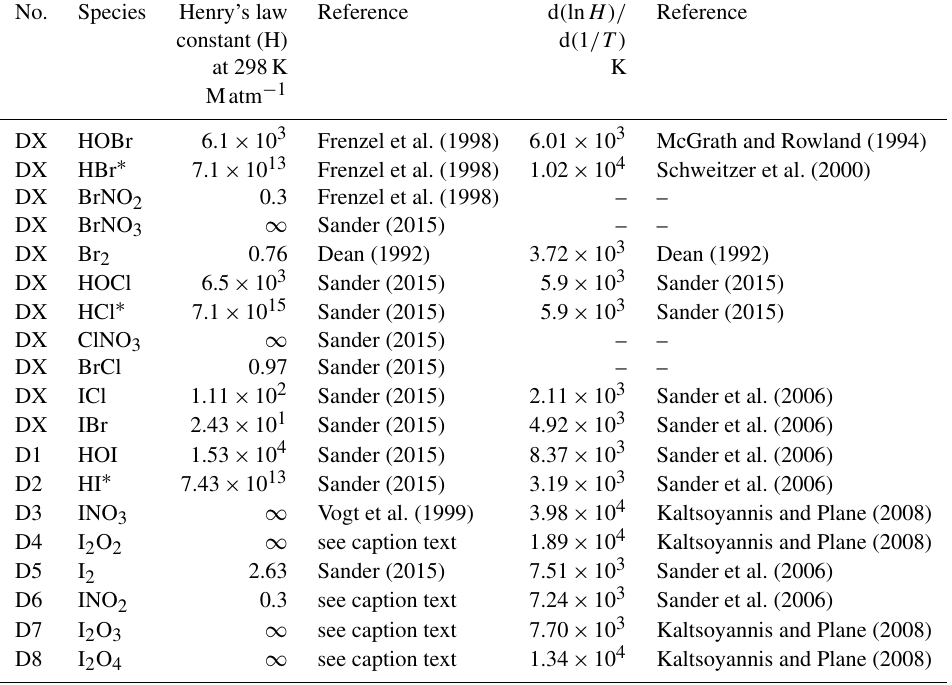
Table B5. Henry’s law coefficients and molar heats of formation of iodine species. Where Henry’s law constant equals infinity a very large values is used within the model (1 × 10 20 Matm − 1 ). The INO 2 Henry’s law constant is assumed equal to that of BrNO 3 , from Sander (2015), by analogy. For I 2 O x ( X = 2, 3, 4) a Henry’s law constant of infinity is assumed by analogy with INO 3